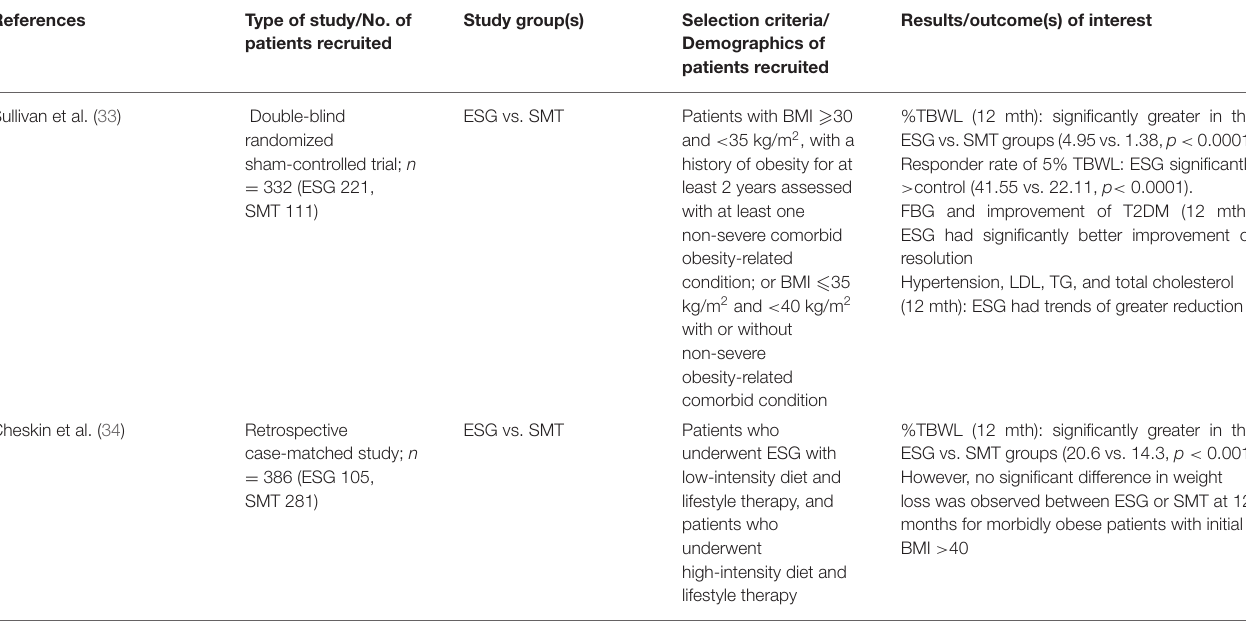
TABLE 4 | Studies included for the study of ESG on Metabolic Syndrome and related comorbidities in